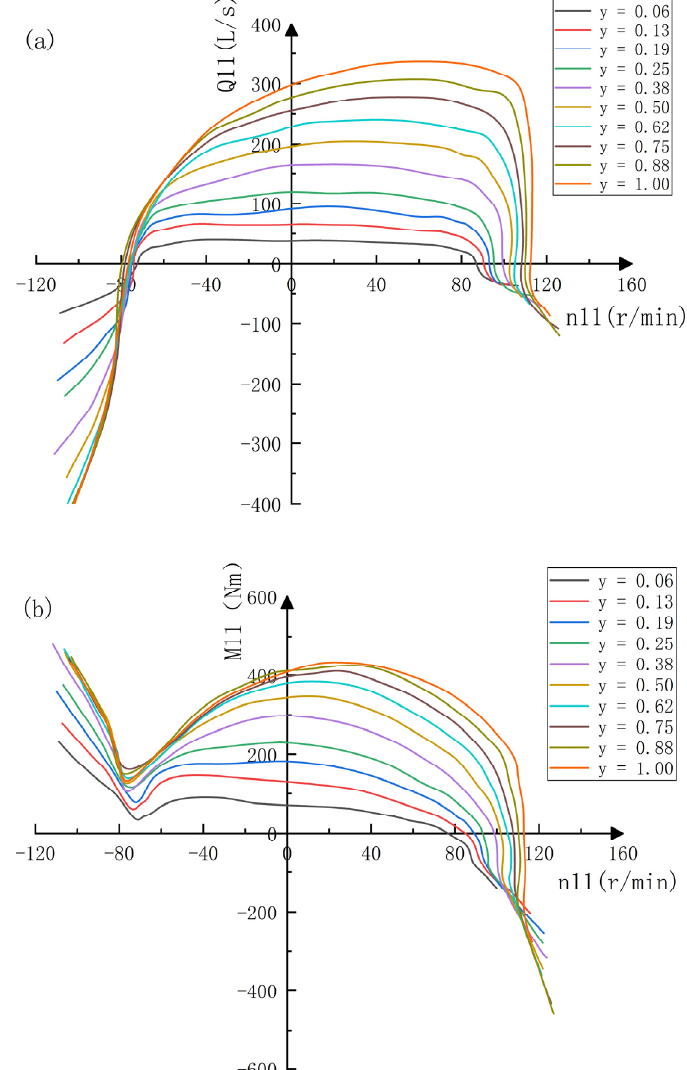
Figure 4. Full characteristic curve of pump-turbine: ( a , b ) are the discharge and torque characteris- tics, respectively.